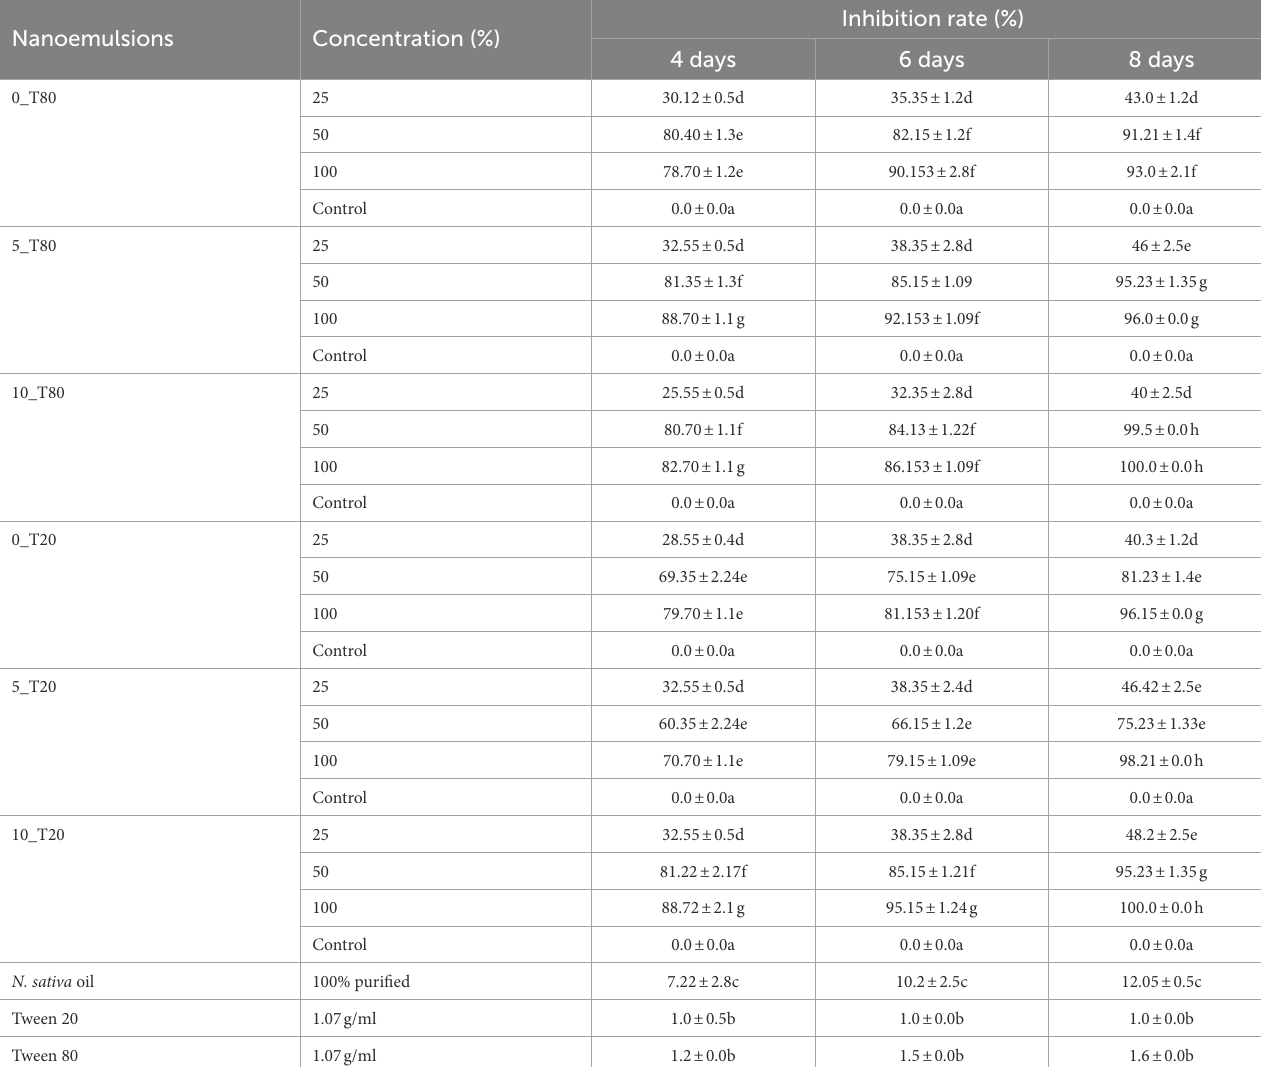
TABLE 1 The antifungal activity of the six different nanoemulsions at three different concentrations against Penicillium verrucosum in compared to untreated control after 4, 6, and 8 days of incubation at 25 ° C ± 1.